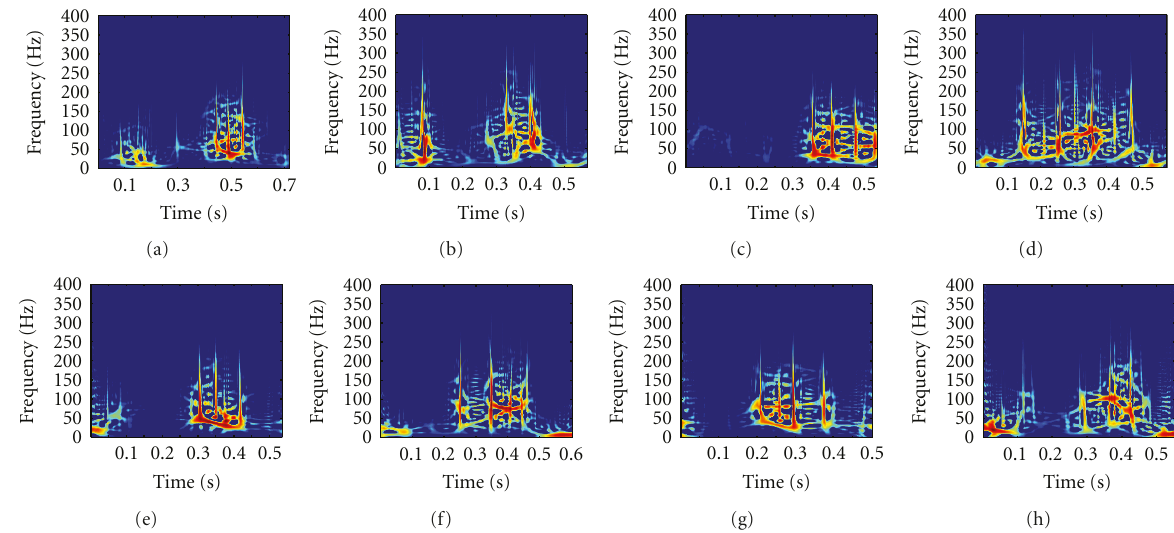
Figure 9: Previous subject’s time-frequency visualizations for (a) S 1 , (b) S 2 , (c) S 3 , (d) S 4 , (e) S 5 , (f) S 6 , (g) S 7 , and (h) S 8 , highlighting overall similarity between distributions.